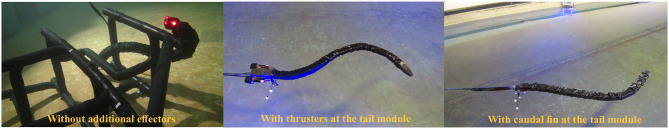
Different configurations of the underwater snake robot Mamba.